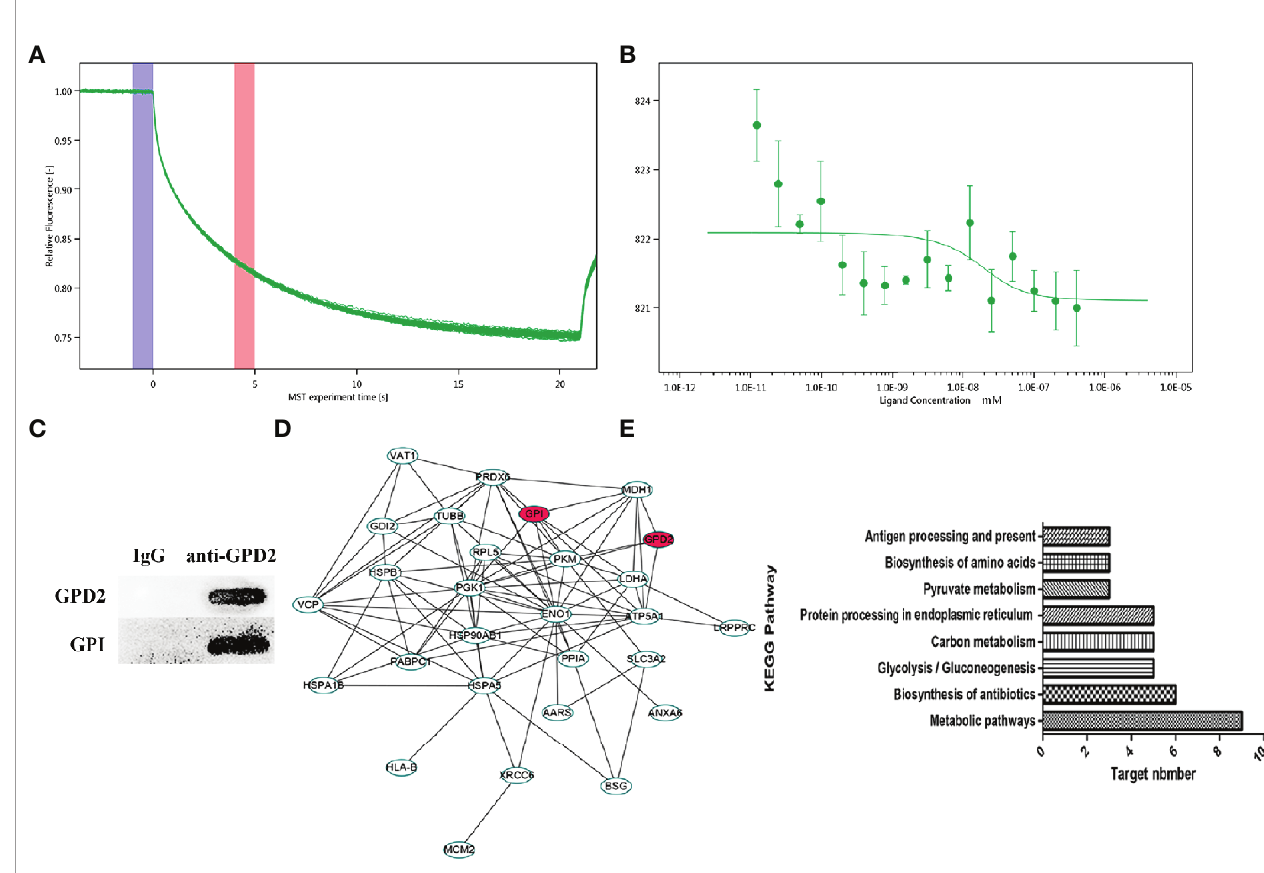
FIGURE 6 | (A , B) MST time traces of 16 different GPI concentrations (1.23 × 10 − 5 to 0.403 µM) with a fi xed concentration of GPD2 (0.02 µM), Kd = 8.59 ± 32.05 nM. MST signal measured 30 s after heating turned on (n=3). (C) The coimmunoprecipitated proteins were detected by western blot. (D) PPI network of differentially proteins. (E) Cancer-related signaling pathways associated with differentially proteins.